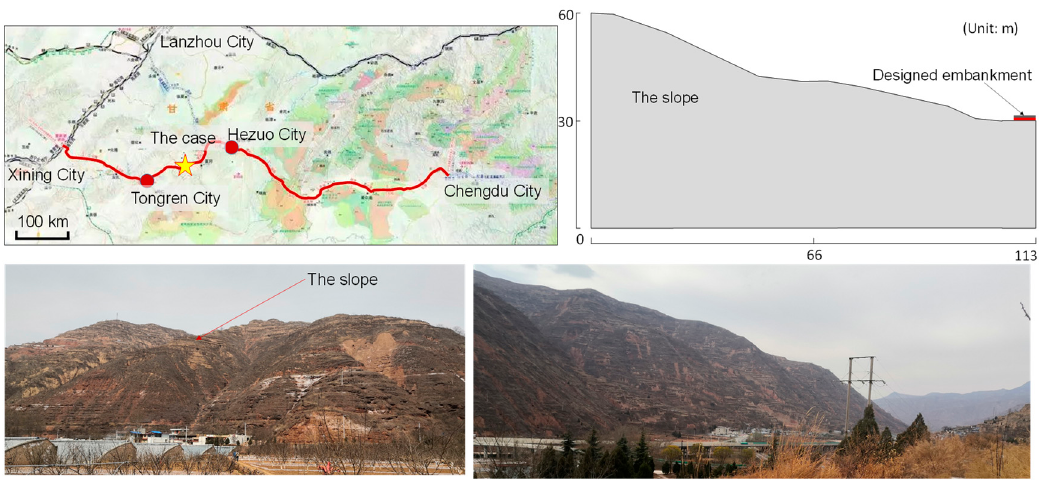
Figure 1. The position, geometry and status of the case in this study.